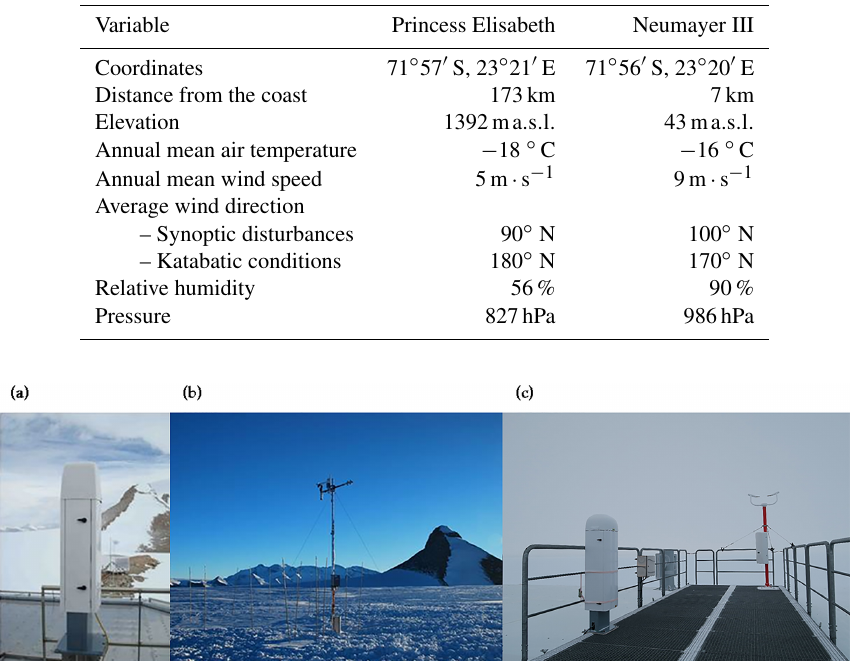
Table 1. Meteorological conditions at Princess Elisabeth and Neumayer III stations. For extended climatology, see Gorodetskaya et al. (2013) for PE station and König-Langlo and Loose (2007) for Neumayer station.